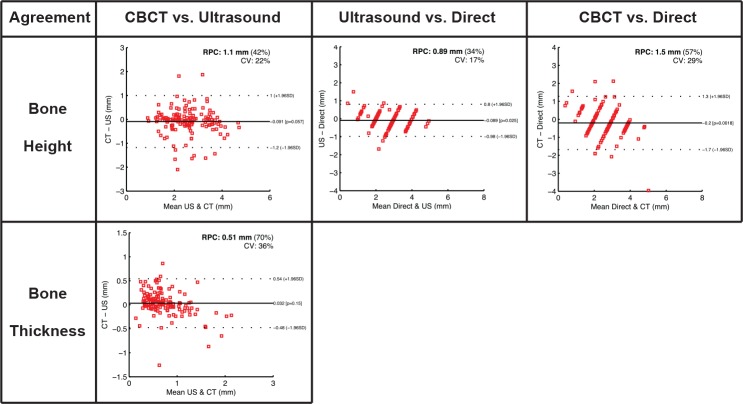
Agreement of bone level and thickness readings between 3 estimation methods.